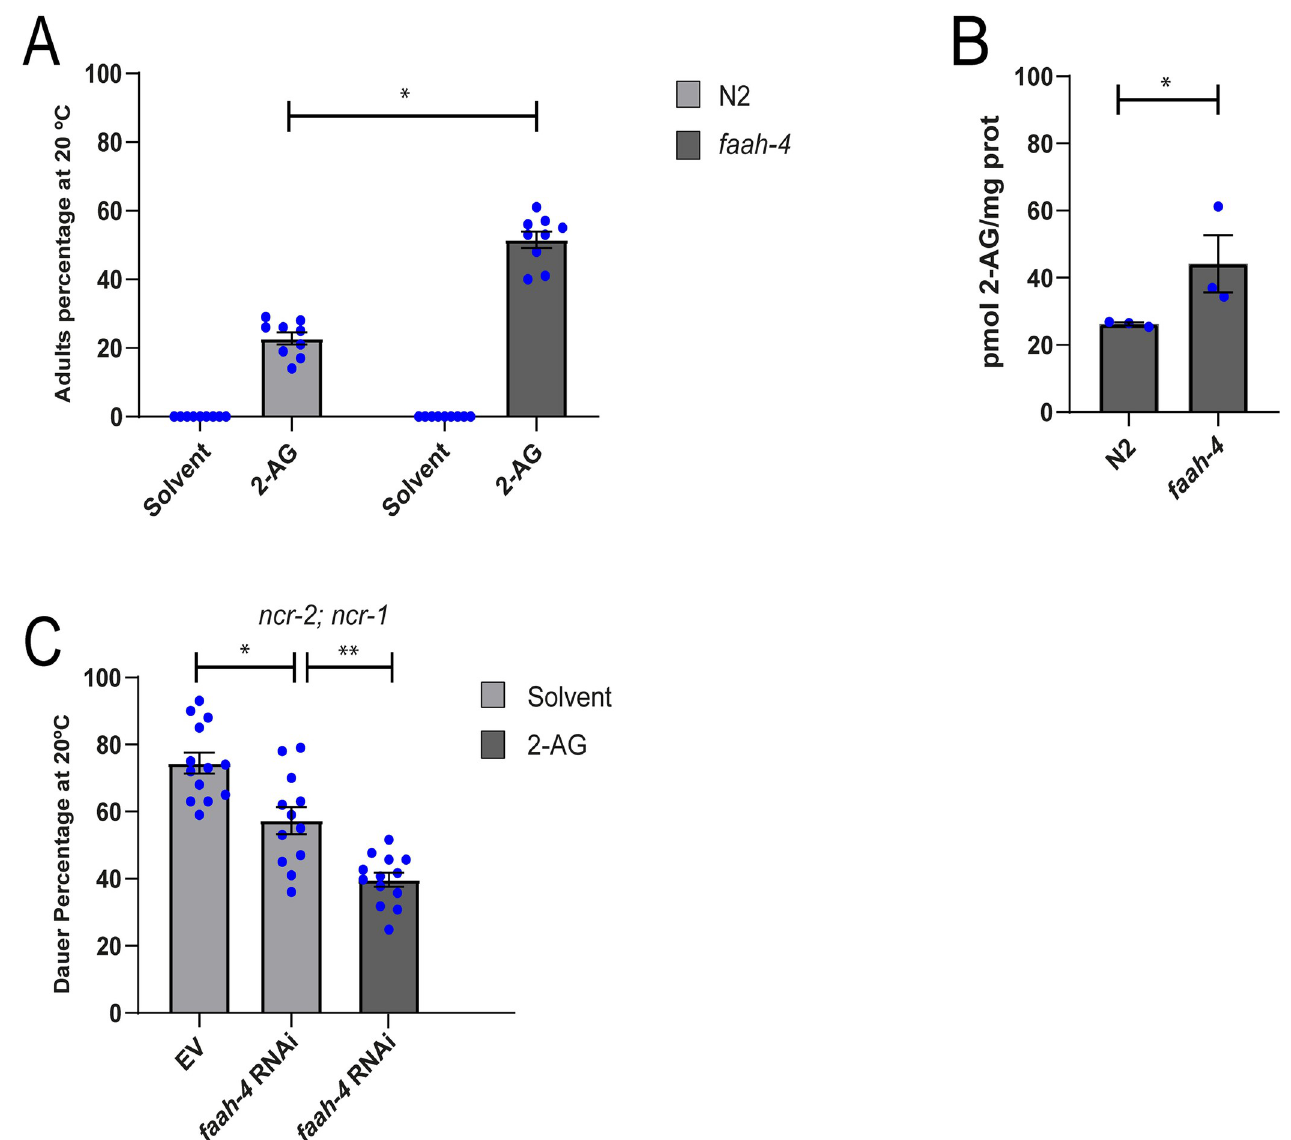
Fig 1. FAAH-4 is involved in cholesterol mobilization by 2-AG. (A) Wild type and faah-4 animals grown for two generations in the absence of cholesterol at 20˚C arrest as L2 � . Feeding with 2-AG (50 μ g/ml) increases the formation of adults in faah-4 animals compared with N2 animals. All Pairwise are Multiple Comparison Procedures (Dunn’s Method), � p < 0.05. All values are from n = 3 independent experiments are shown as Mean ± SEM. (B) Intracellular levels of 2-AG are elevated in faah-4 animals. T-test, � p < 0.005. All values are from n = 3 independent experiments shown as Mean ± SEM. (C) faah-4 RNAi reduces the dauer formation of strain ncr-2; ncr-1 and enhances the ability of low concentrations of 2-AG (10 μ M) to suppress the daf-c phenotype of these animals. All Pairwise are Multiple Comparison Procedures (Holm-Sidak method), � p < 0.002, �� p < 0.001. All values are from n � 3 independent experiments are shown as Mean ± SEM. N2 is the C . elegans wild-type